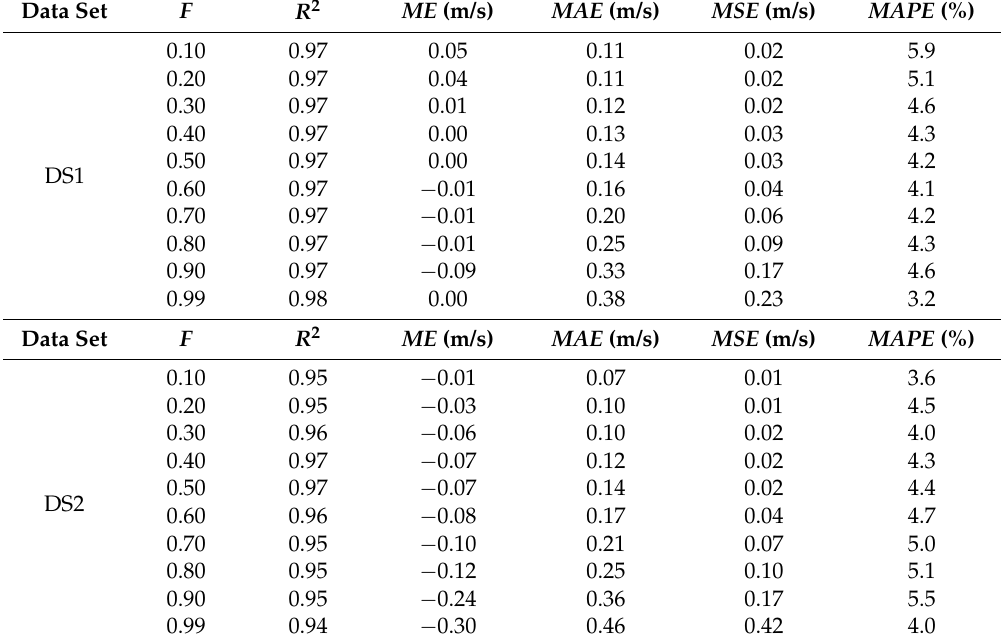
Table 4. Performance measures coefficient of determination ( R 2 ), mean error ( ME ), mean absolute error ( MAE ), mean squared error ( MSE ) and mean absolute percentage error ( MAPE ) calculated from the comparison of empirical and modeled cumulative probabilities ( F ) associated with U 100m -time series included in DS1 and DS2.